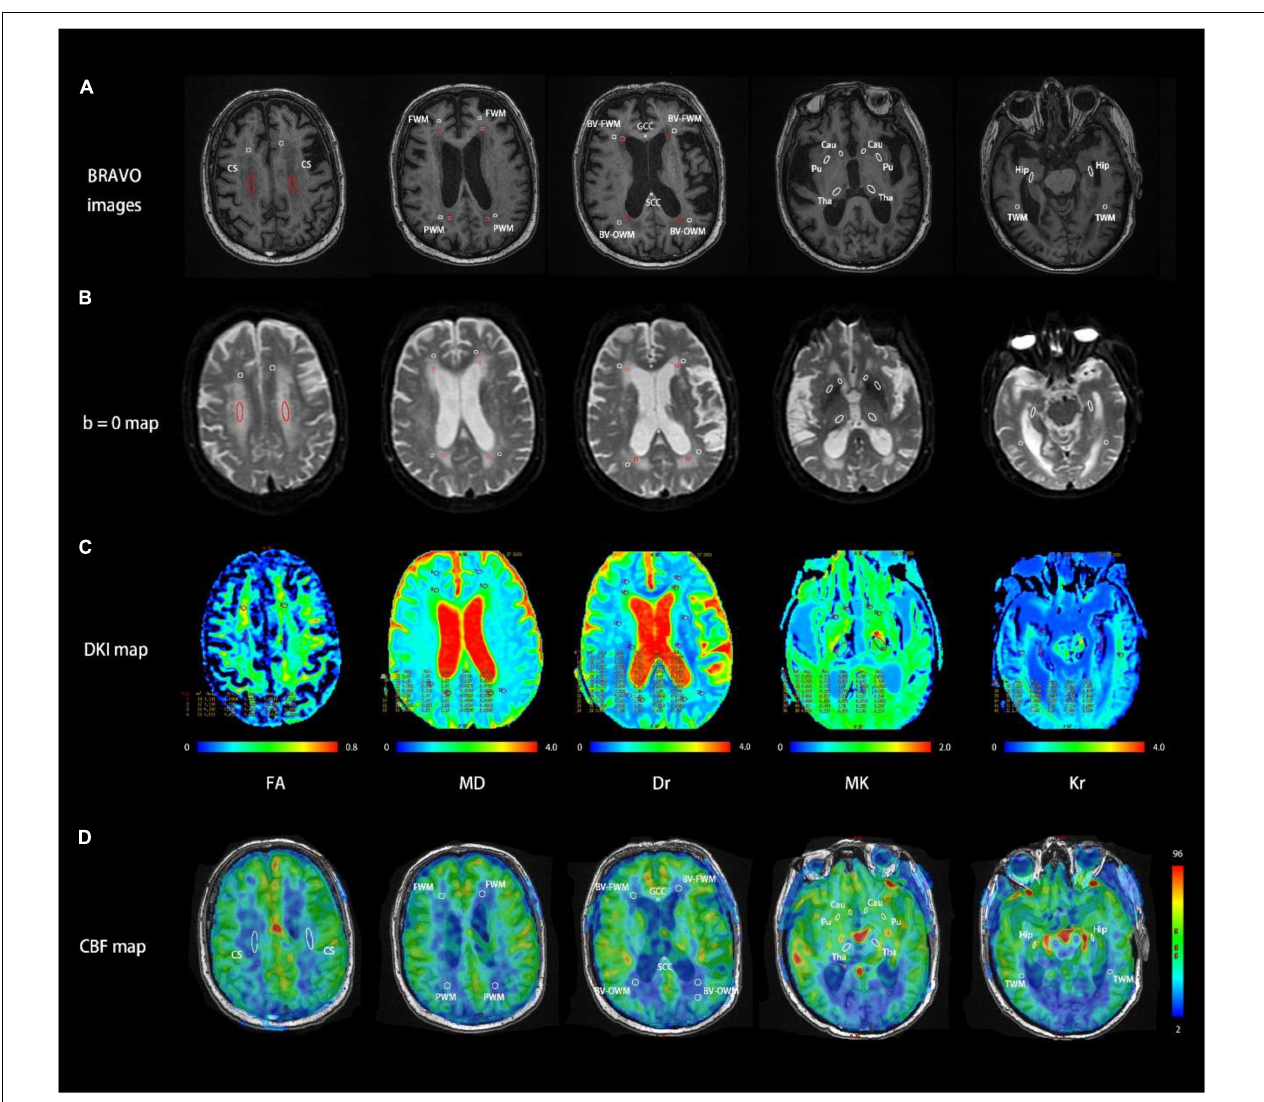
FIGURE 1 | Representative MR images at five consecutive slices of a patient with Binswanger’s disease (BD) acquired using BRAVO image (A) , DKI b = 0 map (B) , DKI parametric maps (C) , and cerebral blood flow (CBF) map (D) . Region of interest (ROI) settings. CS, centrum semiovale; GCC/SCC, genu/splenium of the corpus callosum; FWM/PWM/TWM, frontal/parietal/temporal white matter; BV-FWM/BV-OWM, frontal/occipital white matter around lateral ventricle; Cau, caudate nucleus; Pu, putamen; Tha, thalamus; Hip, hippocampus. Each ROI was also denoted with BRAVO images, b = 0 maps, and DKI/ASL-derived parameters maps. The red ROIs in b = 0 maps and BRAVO images represent white matter hyperintensities and the white ROIs in both maps represent normal areas in MRI. TABLE 2 | Geometric information of each region of interest (ROI) selected in multiple brain functional subregions. Region (mm 2 ) Centrum semiovale GCC/SCC/TWM FWM/PWM/BV-FWM/BV-OWM Caudate nucleus Putamen Thalamus Hippocampus Groups Lesion Normal